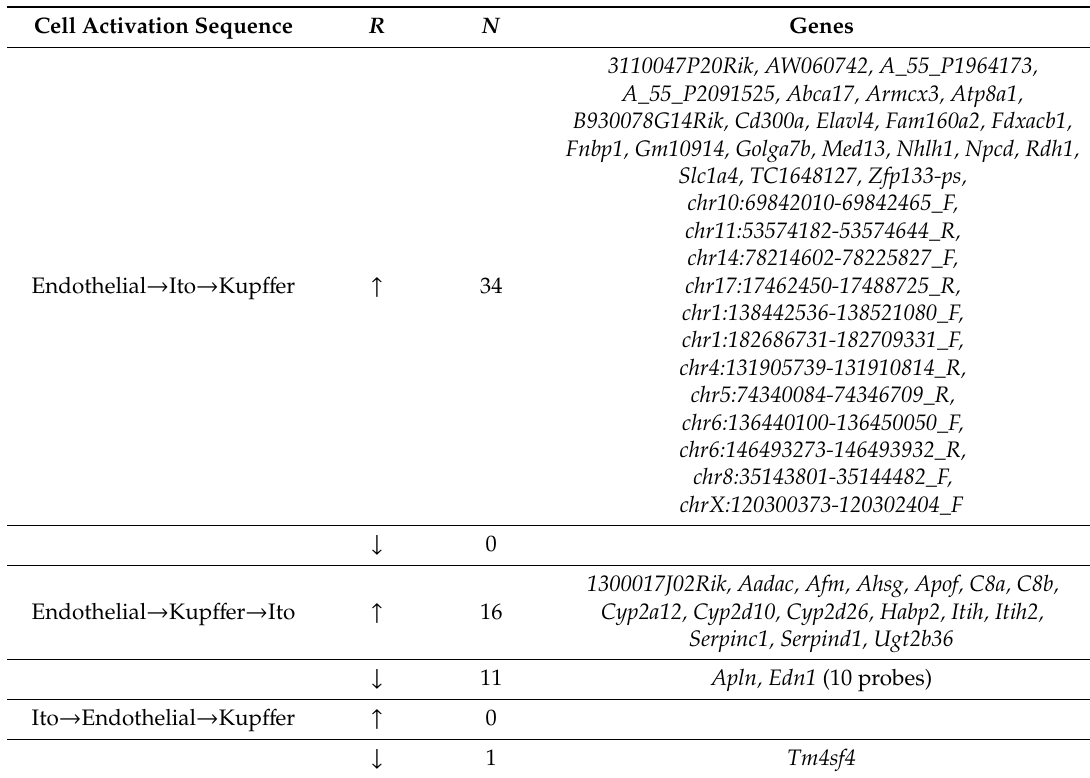
Table 1. Cell activation sequence in the tumor cells (fold change 2 in log 2 scale). For each mRNA sample, we used 4 biological replicates.